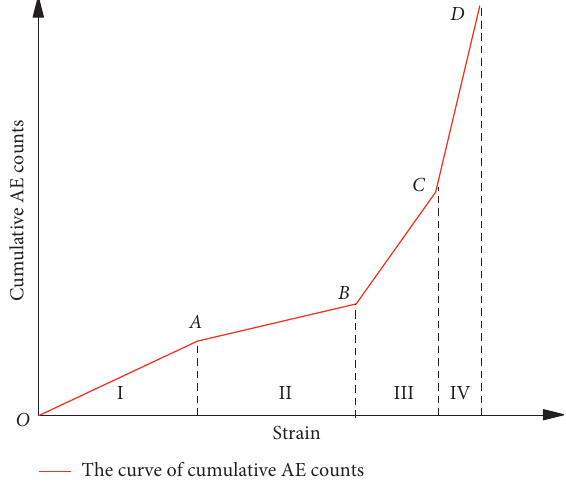
Figure 8: Cumulative curve of acoustic emission during coal sample